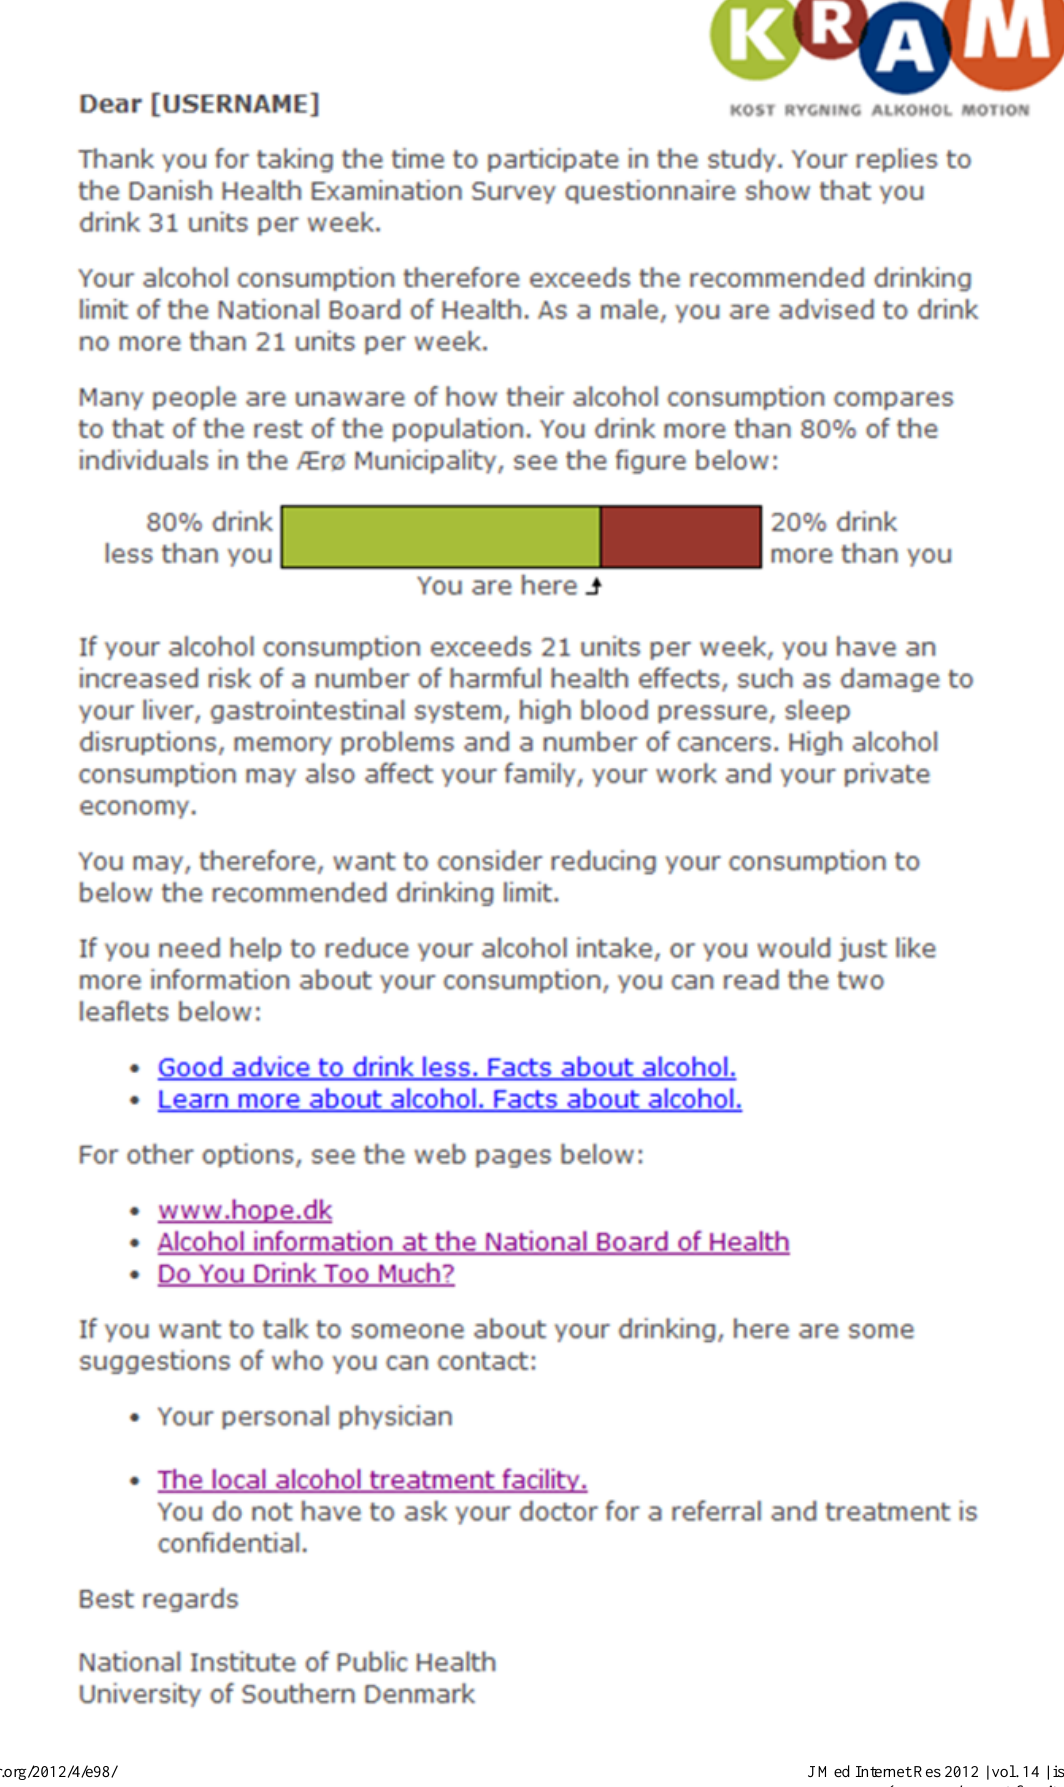
Figure 1. Screenshot of the Internet-based brief personalized feedback